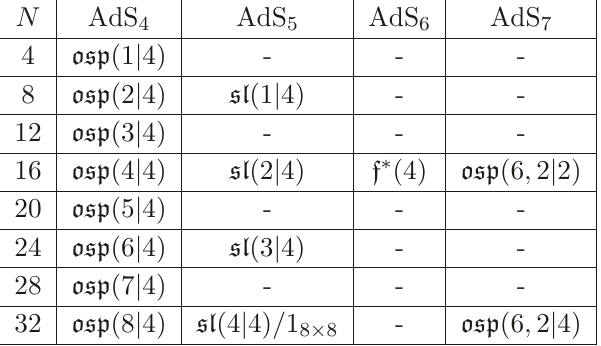
Table 4 . In all cases, for AdS k backgrounds g 0 = so ( k − 1 , 2) ⊕ t 0 . f ∗ (4) is a different real form to f (4) which appears in the AdS 3